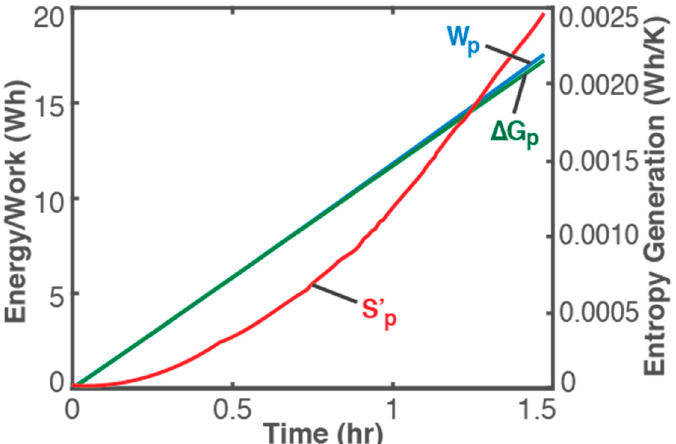
(cid:82) Figure 2. Ohmic work W p = ∫ t VI dt (blue plot, left axis), Gibbs free energy ∆ G p = V 0 q rev (green plot, left Figure 2. Ohmic work W p = t VI dt (blue plot, left axis), Gibbs free energy axis), and entropy generation S’ p from equation (20) (red plot, right axis) during a 1.5 h constant- plot, left axis), and entropy generation S’ p from Equation (20) (red plot, right axis) during a 1.5 h current charge of a 3.7 V, 11 Ah Li-ion battery of 3 A. constant-current charge of a 3.7 V, 11 Ah Li-ion battery of 3